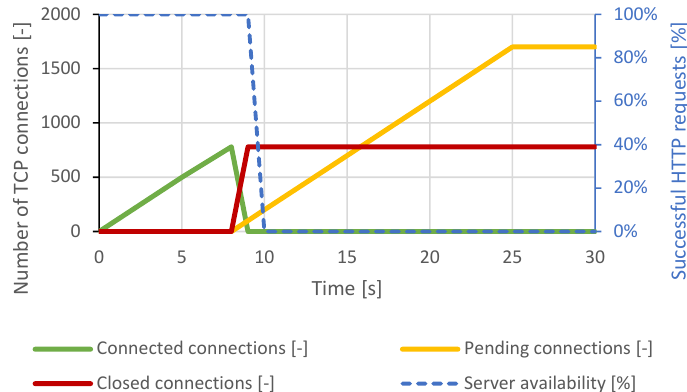
Figure 11. Slowcomm attack against Nginx